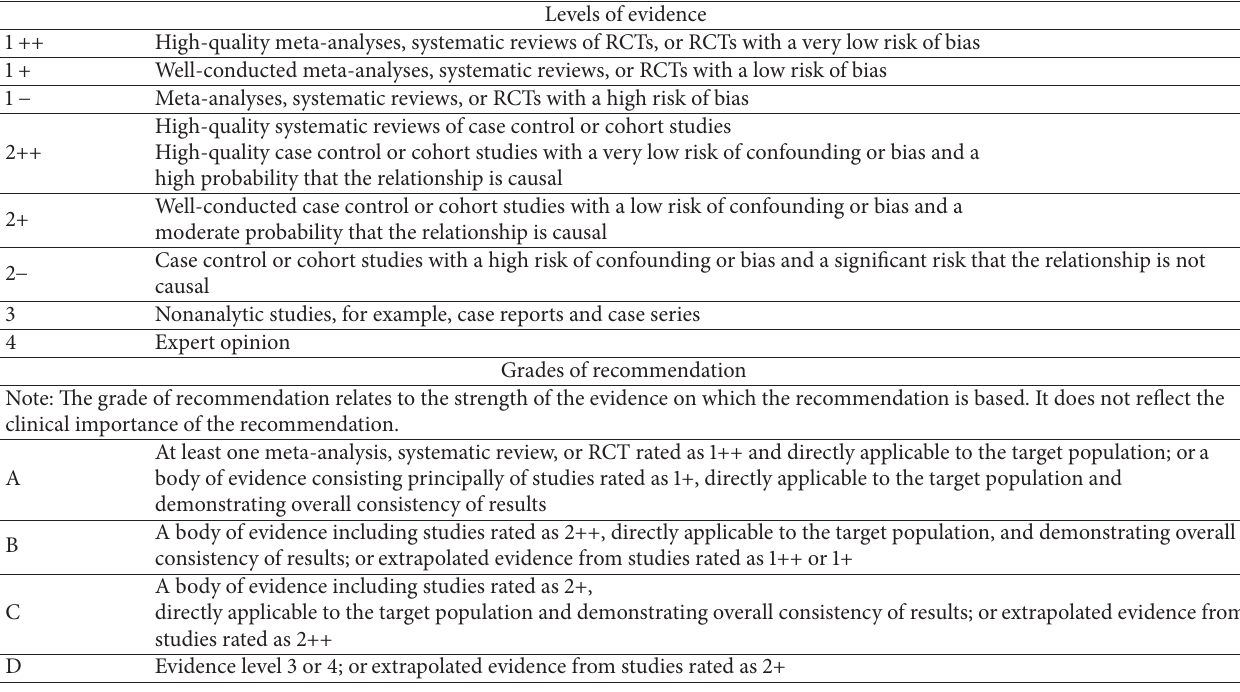
Table 5: BTS/SIGN guideline.